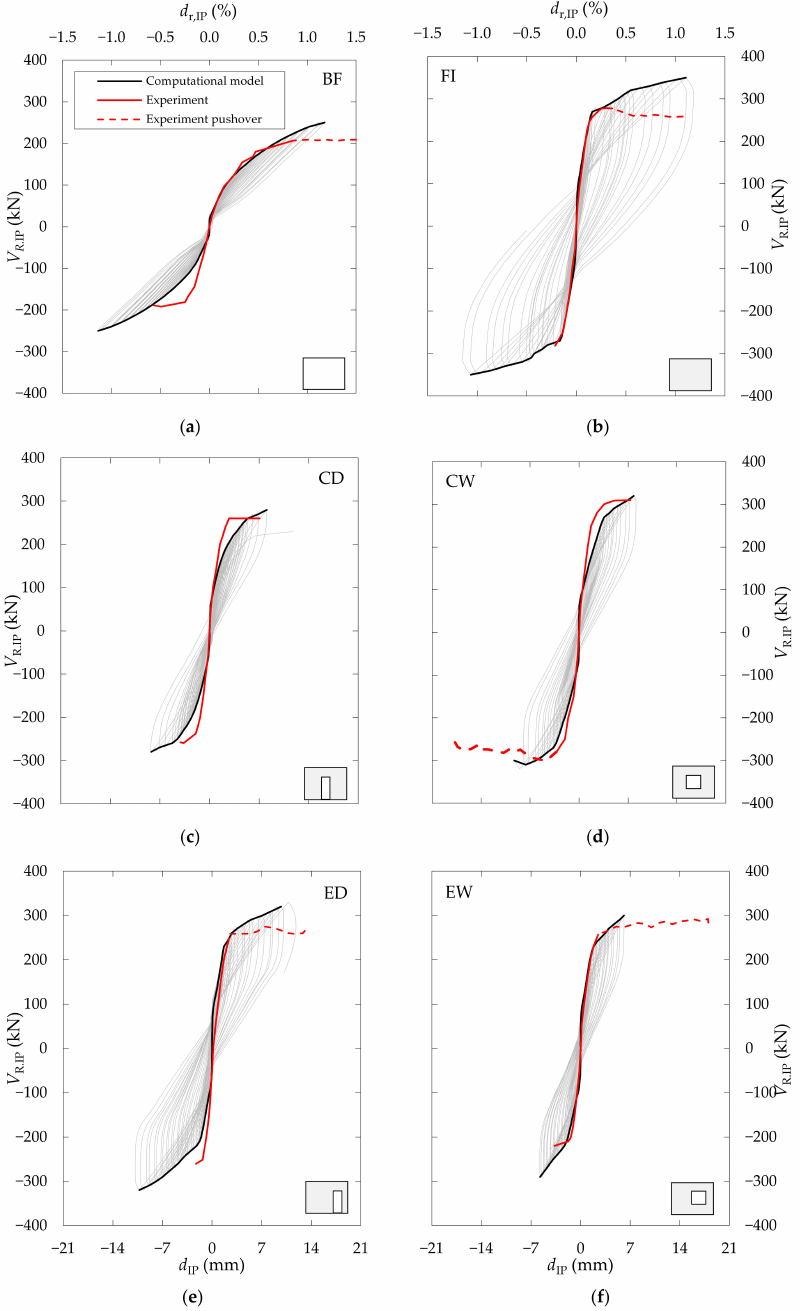
Figure 22. Calibrated cyclic, quasi-static IP micromodel response (results from models calibrated in both IP and OoP direction): ( a ) bare rc frame case; ( b ) full-infilled frame case; ( c ) centric door opening case; ( d ) centric window opening case; ( e ) eccentric door opening case; ( f ) eccentric window opening